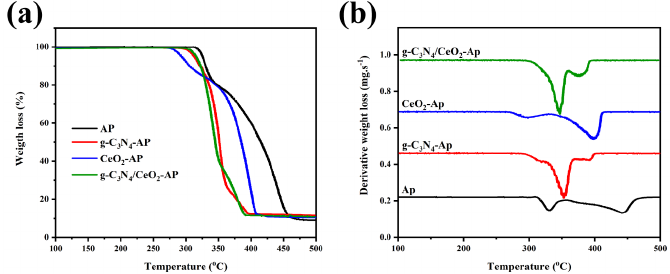
Figure 19. ( a ) TG and ( b ) DTG curves of pure ammonium perchlorate (AP), AP coupled with g-C 3 N 4 , CeO 2 , and g-C 3 N 4 /CeO 2 heterojunction, Copyright © 2022 Elsevier [460]. Methylene Blue (MB), Methylene Orange (MO), and Rhodamine B (RhB) are the most commonly stable dyes in water at room temperature [461 – 468]. MB and RhB are toxic dyes that their high concentration can be so harmful to human and marine animal health. In accordance with the high resistivity of the MB and RhB in different environmental condi- tions, wastewater treatment is an urgent issue. Therefore, it is crucial to provide an effec- tive and low-cost system to eliminate MB and RhB from sewage. As mentioned above, 2D/1D g-C 3 N 4 /ZnO nanocomposites reveal high stability, which retains the initial activity after repeated cycles [469]. The enhanced photocatalytic activity of g-C 3 N 4 -ZnO is likely due to the synergistic effects of photon acquisition and direct contact between organic dyes and photocatalyst [470]. To be more specific, the RhB dye degradation efficiency of this composite is 99% and 95% after one and three cycles under sunlight irradiation, re- spectively [471]. It is reported that the highest degradation efficiency for MB is obtained for the 30 wt % few-layer g-C 3 N 4 -ZnO nanocomposites is the best composition [472]. The higher amount of g-C 3 N 4 can increase the electrons and holes recombination, leading to